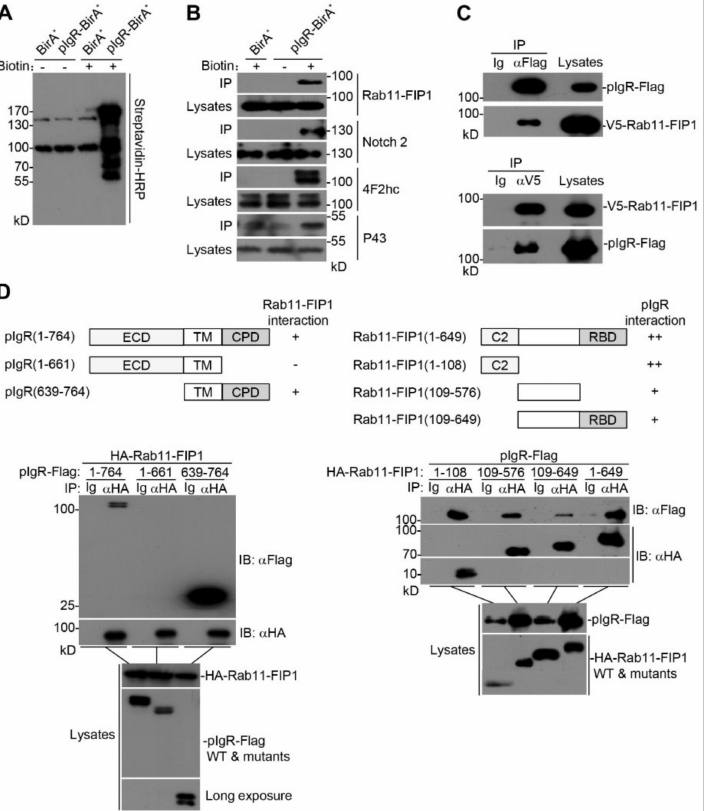
Figure 1. Rab11 − FIP1 interacts with pIgR. ( A ) HEK293T cells (2 × 10 6 ) were transfected with pIgR − BirA* or BirA* plasmids for 24 h. Cells were untreated or treated with 50 µ M biotin for 12 h before lysis in the indicated buffer. Biotin − labelled proteins were immunoprecipitated from lysates using streptavidin conjugated agarose beads. Immunoprecipitated proteins were detected by immunoblotting analysis and identified by mass spectrometry. ( B ) The samples of ( A ) were respectively detected by immunoblotting analysis with the indicated antibodies. ( C ) Detection of the interaction between Rab11 − FIP1 and pIgR. HEK293T cells (2 × 10 6 ) were co − transfected with the indicated plasmids for 24 h. Coimmunoprecipitation and immunoblotting analyses were performed with the indicated antibodies. ( D ) Domain mapping of the interaction between Rab11 − FIP1 and pIgR. HEK293T cells (2 × 10 6 ) were co − transfected with the indicated plasmids for 24 h. Coim- munoprecipitation and immunoblotting analyses were performed with the indicated antibodies. ECD: ectodomain; TM: transmembrane domain; CPD: cytoplasmic domain. ++: stronger interaction, +: interaction, − : no interaction. Data of ( A – D ) are representative of three independent